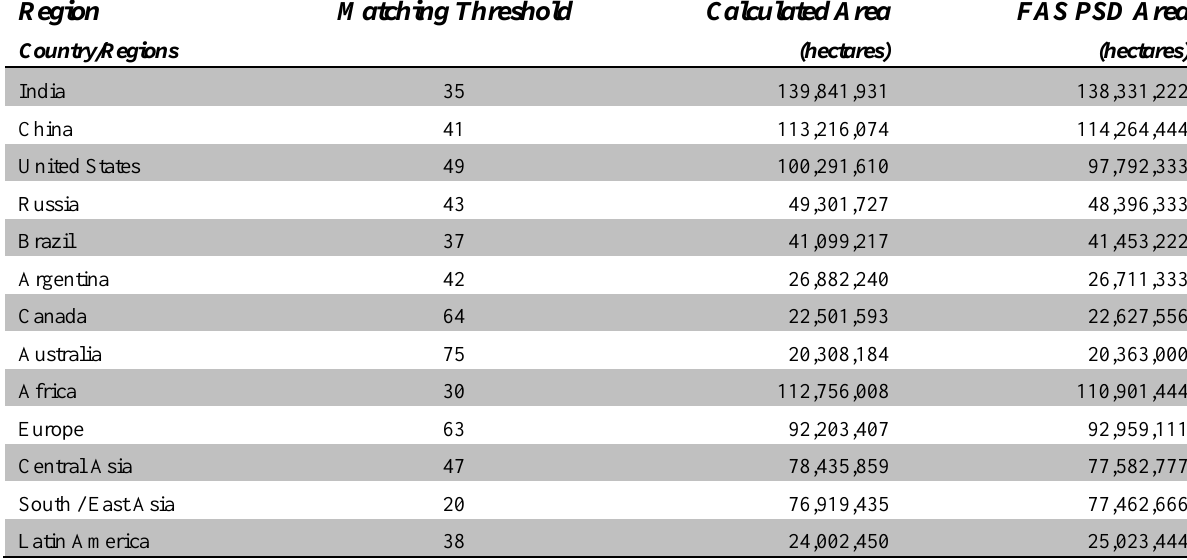
Table 4. MODIS cropland probability layer converted to cropland mask by employing a per country area-matching threshold using USDA FAS PSD country data. Calculated areas shown in this table for regions are derived from summing the per country totals. Matching thresholds for regions were calculated independently to ease intercomparison.